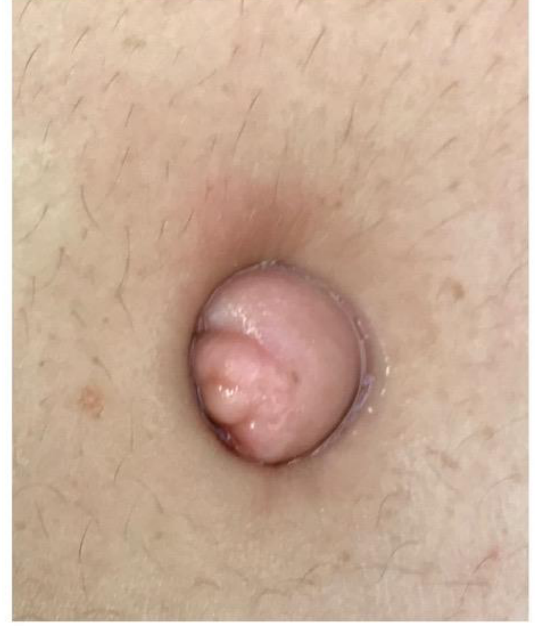
Figure 2. Endometriosis infiltrating the entire skin aspect of the umbilicus.